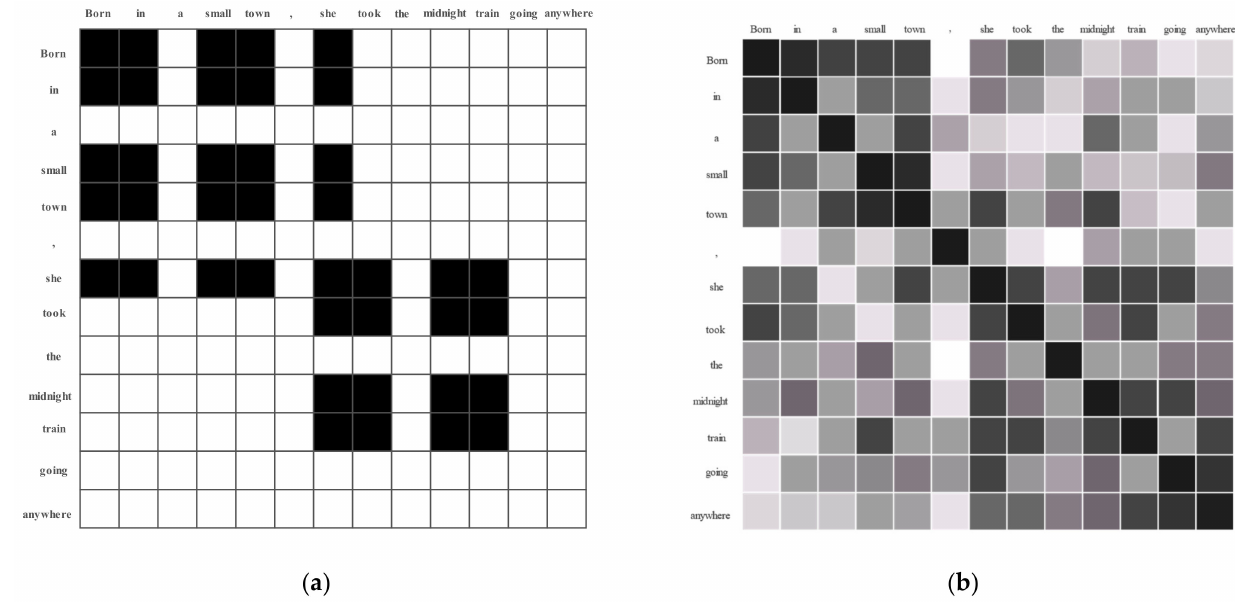
Figure 3. An example of factual relation mask matrix ( a ) in left and attention matrix ( b ) in